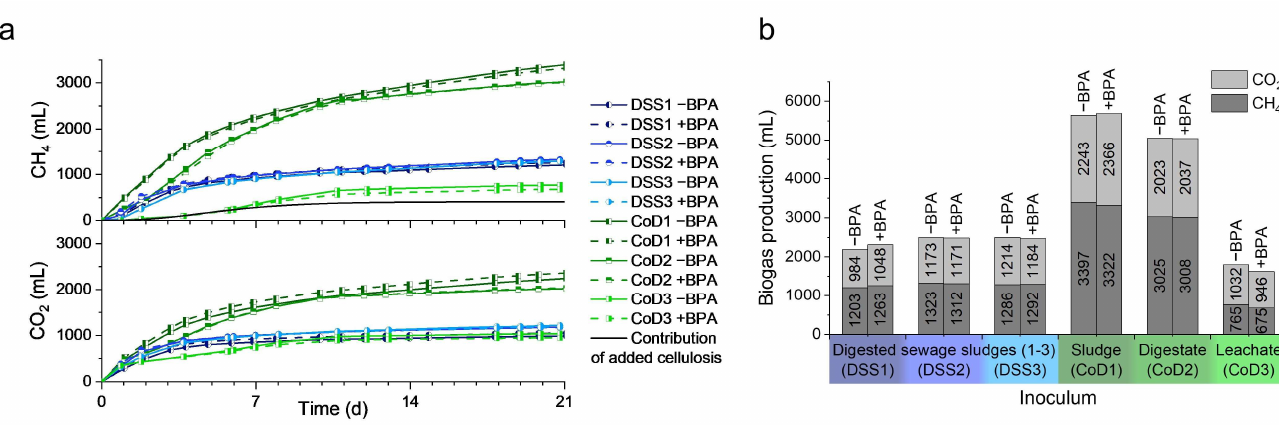
Figure 3. Biogas production of different inoculates with and without additional bisphenol A: (a) Methane and carbon dioxide curve over 21 days. Three digested sewage sludges (DSS1–3), and three co-digester inoculates (CoD1–3) were tested with additional BPA (+BPA, dashed lines) and without (−BPA, solid lines). ( b ) The total methane and carbon dioxide yields for 21 days. Differences due to BPA addition were not statistically significant (paired t -test, n = 6, p = 0.39 for methane and p = 0.67 for carbon dioxide production).